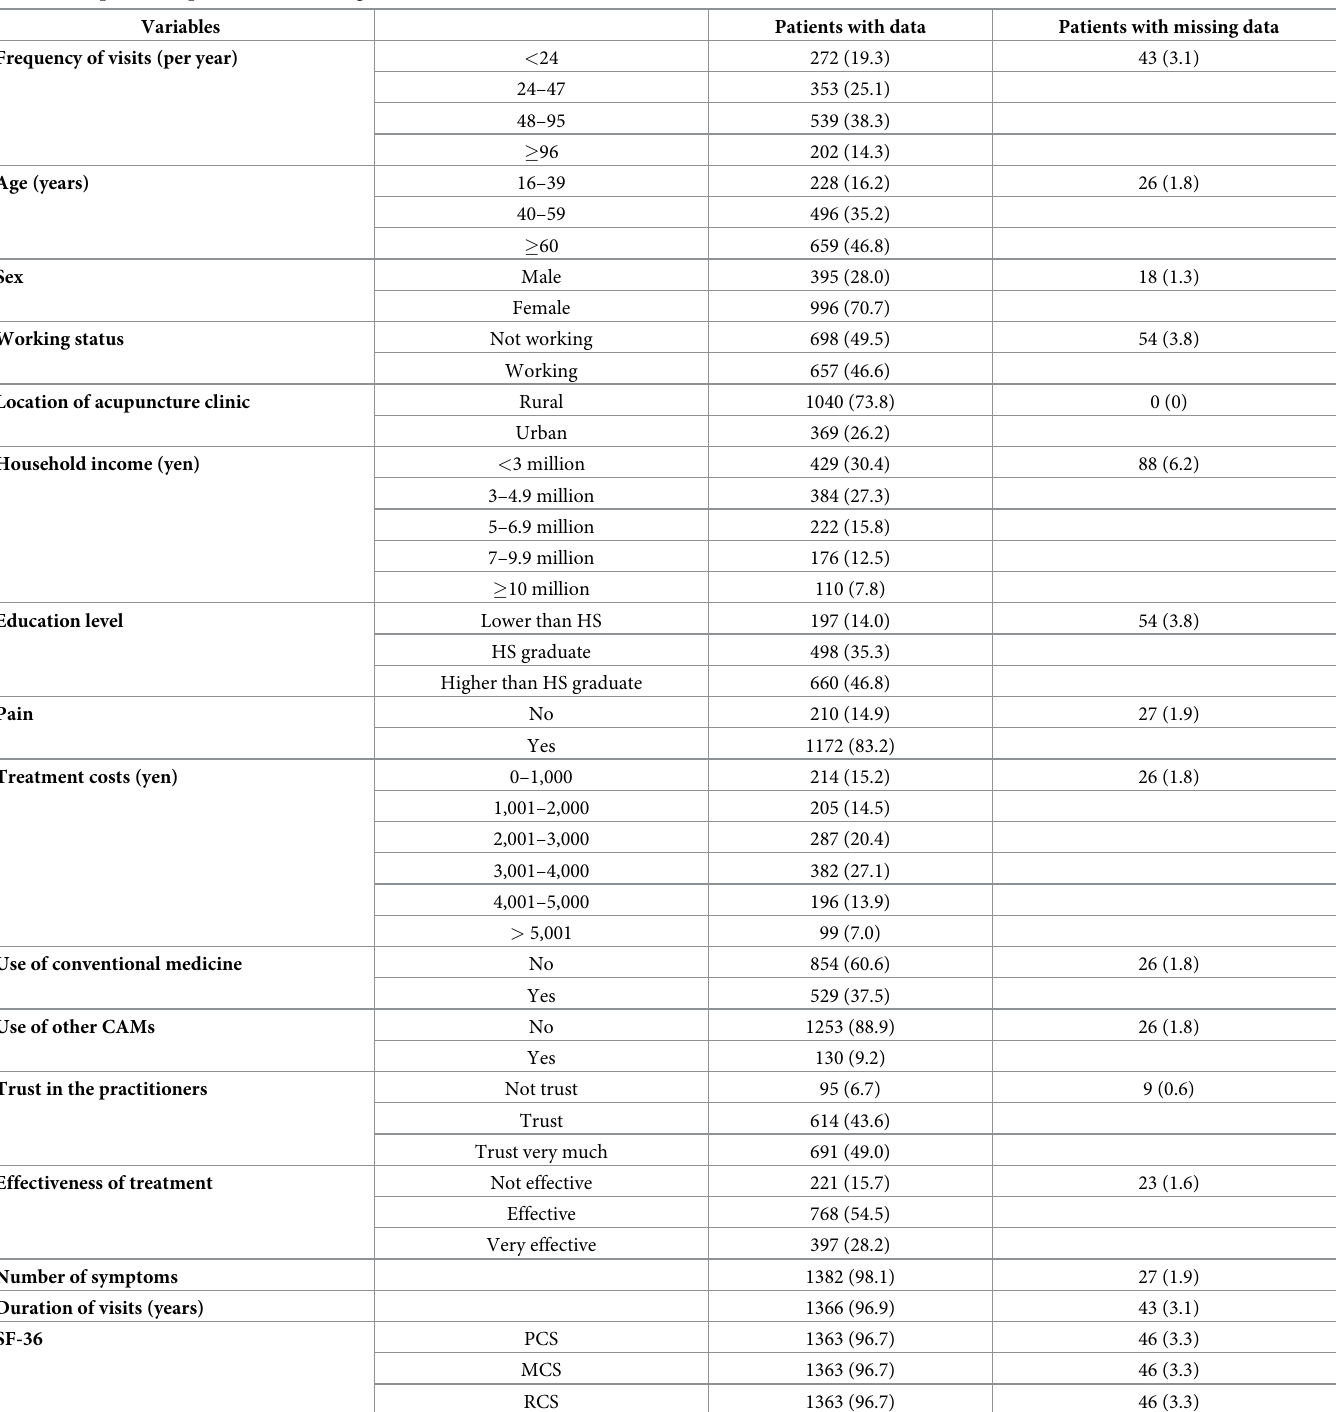
Table 1. Proportion of patients with missing data for each